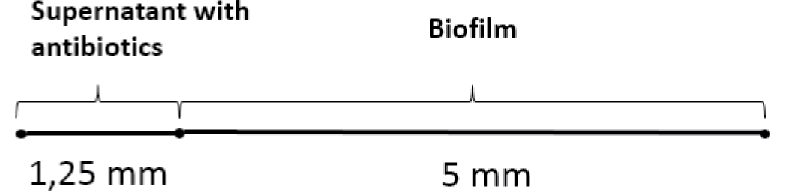
Fig 3. Geometry of ciprofloxacin model coupled with oxygen treatment. Sketch of the 1-dimensional model implemented in MATLAB. The origin is placed at the interface between the supernatant and the biofilm domains, hence the top of the supernatant has coordinate z = −1.25 mm, the top of the biofilm has z = 0 mm, and the bottom of the biofilm has coordinate z = 5